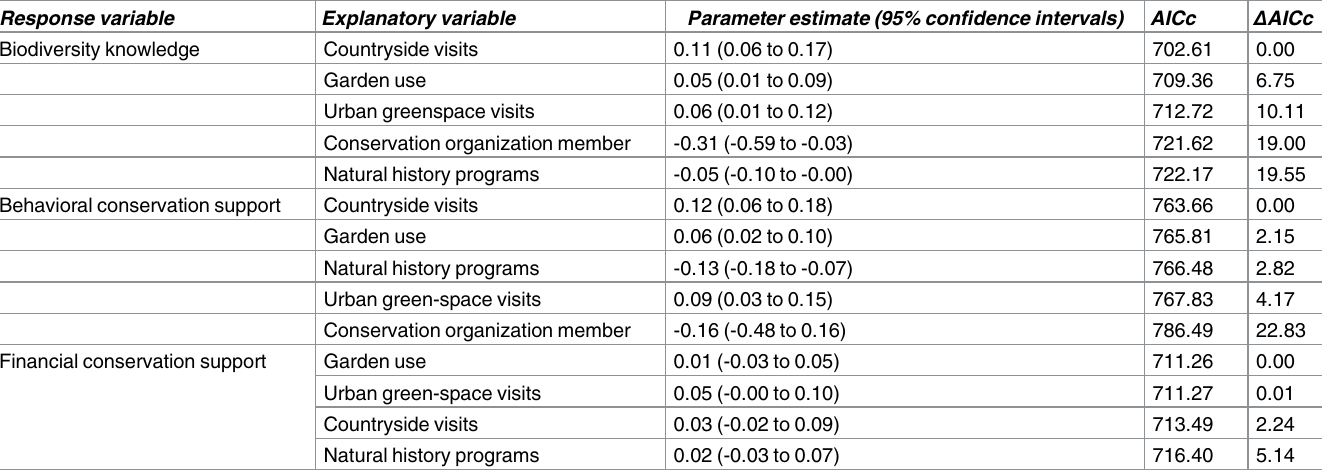
Table 2. Regression models of biodiversity knowledge and conservation support as a function of both green-space visitation rates (countryside and urban green-space) and potentially confounding factors (garden use, natural history program engagement and being a member of a conser- vation